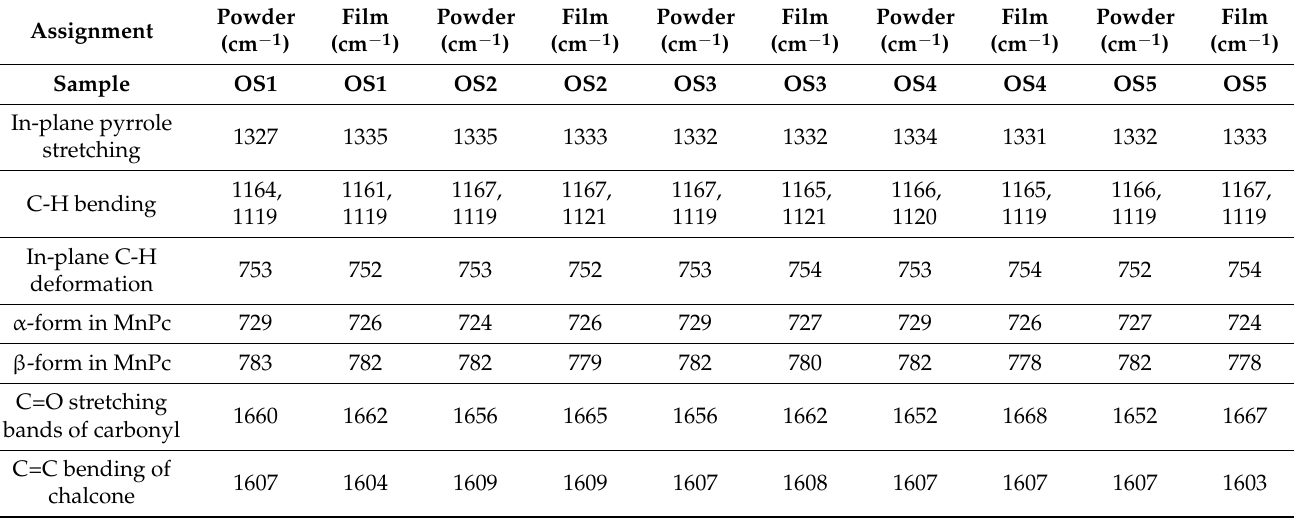
Table 1. Band positions and assignments of MnPcCl–chalcone semiconductors in KBr pellets (powder) and